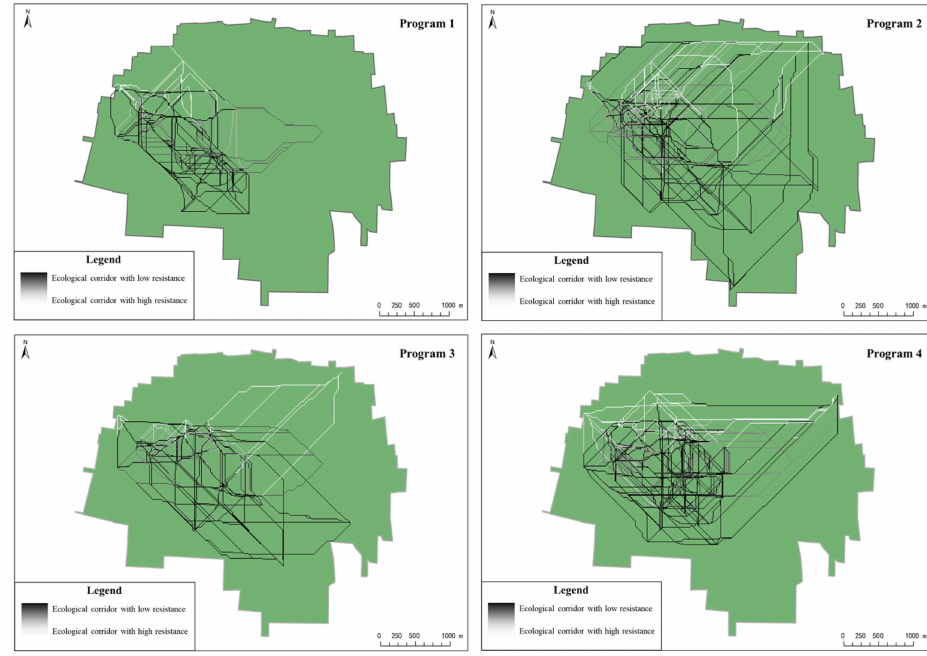
Figure 7. Potential ecological corridors for the alternative planning programs of Zepan